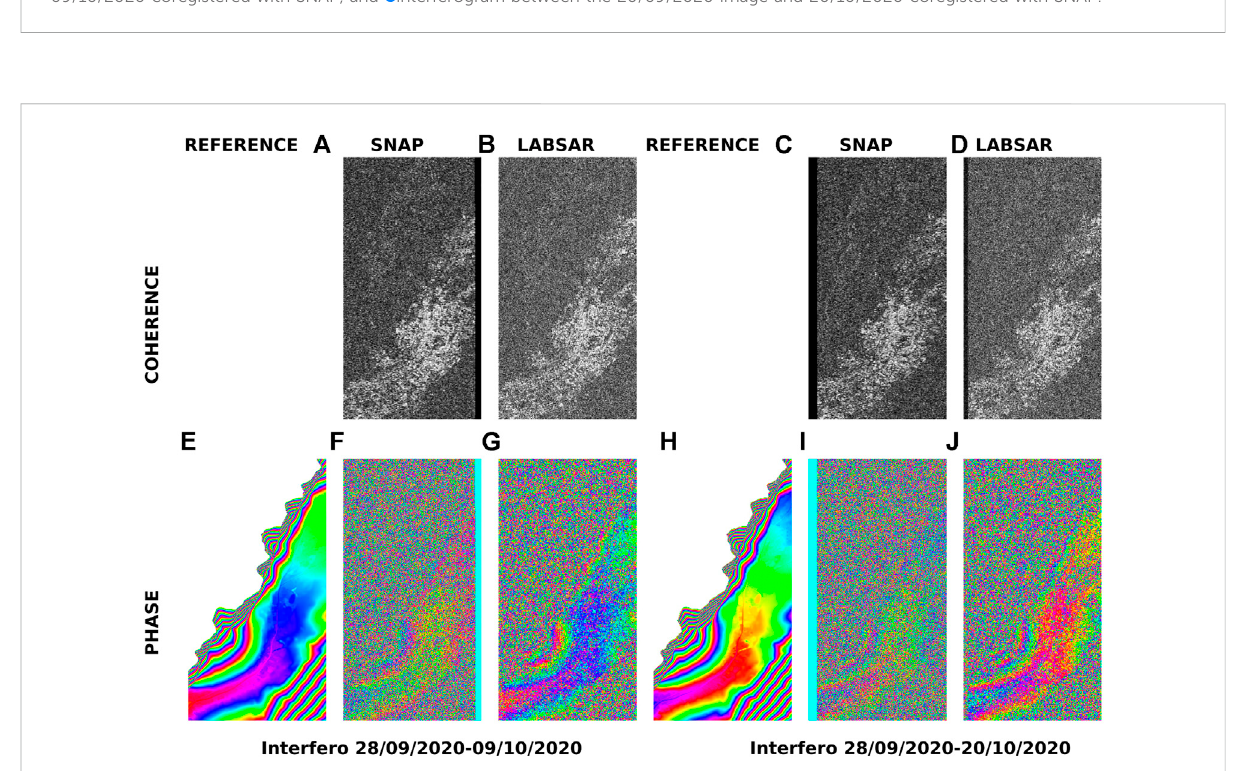
FIGURE 7 Coherence and phase of the interferogram after obrital fringes removal. (A – D) coherence and (E – J) phase of the interferograms. (A,B,E,F,G) between the 28/09/2020 and 09/10/2020 images. (C,D,H,I,J) between the 28/09/2020 and 20/10/2020 images. (E,H) simulated phase, (A,C,F,I) SNAP resampling, and (B,D,G,J) the LabSAR